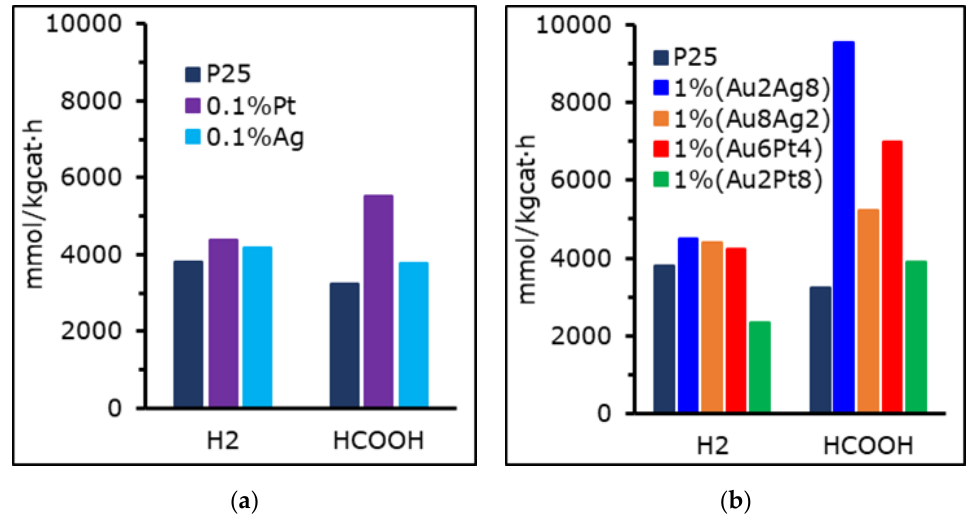
Figure 6. Productivity of HCOOH and H 2 for ( a ) mono − metallic and ( b ) bi − metallic photo-catalysts from CO 2 photo-reduction activity tests performed at 8 bar and pH = 14.